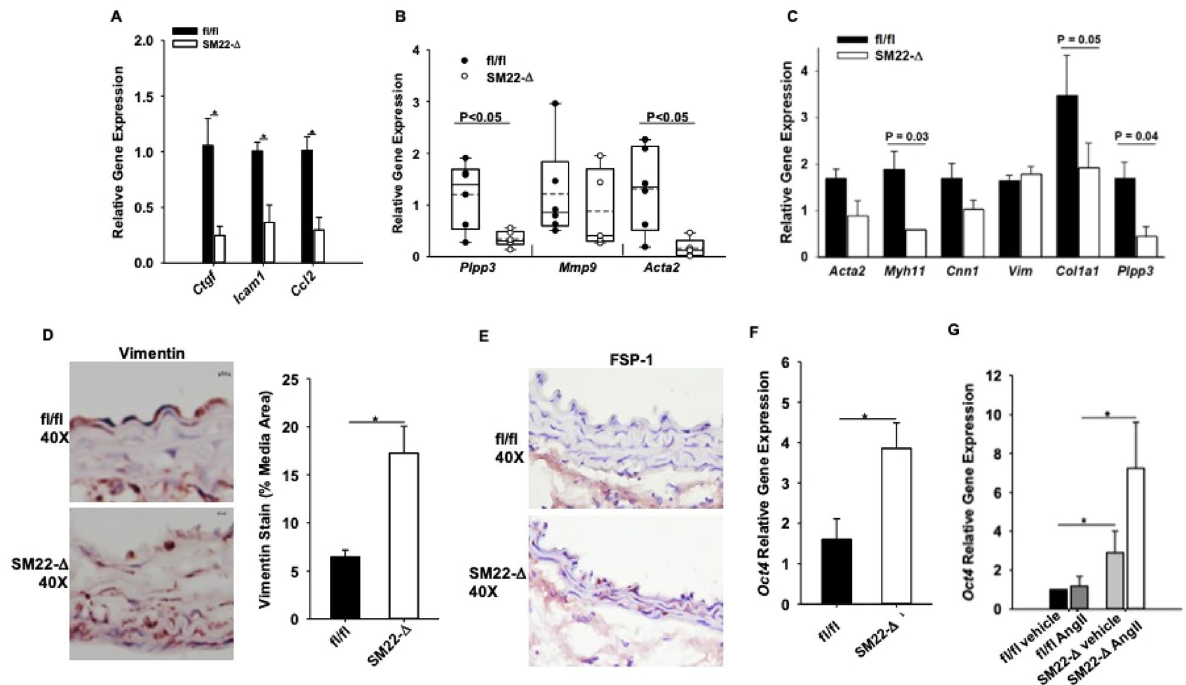
Figure 5. Reduced inflammation in SM22-Δ abdominal aorta. ( A ) Gene microarray were performed in abdominal aorta following 1 week AngII infusion in fl/fl (n = 3) and SM22-Δ (n = 3) mice, * P < 0.05, unpaired two-tailed student t-test. Relative gene expression was calculated using an average CT value from fl/fl mice treated with AngII for 1 week. fl/fl mice treated with AngII for 1 week were used as the control and compared to SM22-Δ mice treated with AngII for 1 week. ( B ) Abdominal aorta gene expression from fl/fl (n = 4) and SM22-Δ (n = 3) mice following AngII treatment. Data is represented as relative gene expression, * P < 0.05, unpaired two-tailed student t-test. Relative gene expression was calculated using an average CT value from fl/ fl mice treated with AngII for 1 week. fl/fl mice treated with AngII for 1 week were used as the control and compared to SM22-Δ mice treated with AngII for 1 week. ( C ) Gene expression of isolated aortic SMC from fl/ fl (n = 3) and SM22-Δ (n = 3) following 24 h AngII treatment. Relative gene expression was calculated using an average CT value from fl/fl mice treated with AngII for 1 week. fl/fl mice treated with AngII for 1 week were used as the control and compared to SM22-Δ mice treated with AngII for 1 week. ( D ) Representative vimentin stained abdominal aorta from fl/fl andSM22-Δ mice following 1 week AngII infusion and percent area of vimentin stain in abdominal aortas from fl/fl (n = 4) and SM22-Δ (n = 3). Vimentin stain was quantified